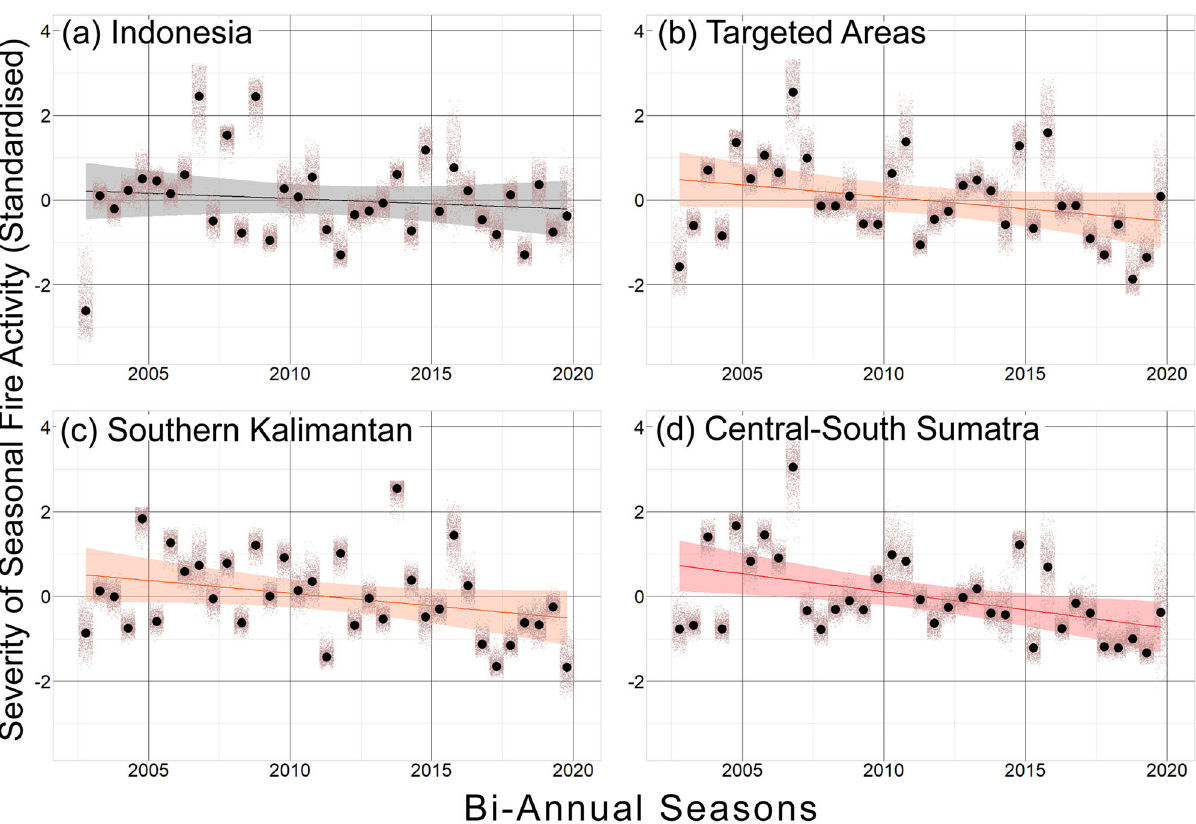
Fig. 3 Declining severity of seasonal fi re activity, controlling for precipitation, for Indonesia, Targeted Areas, Southern Kalimantan, and Central-South Sumatra. Trends describe skewness of seasonal fi re-event severity, controlling for precipitation, standardised per region. The cloud of points around each datum denotes the spread of bootstrapped model residuals. Red and orange trend lines and 95% con fi dence envelopes indicate trend signi fi cance, at p < 0.05 for d and p < 0.1 for b , c